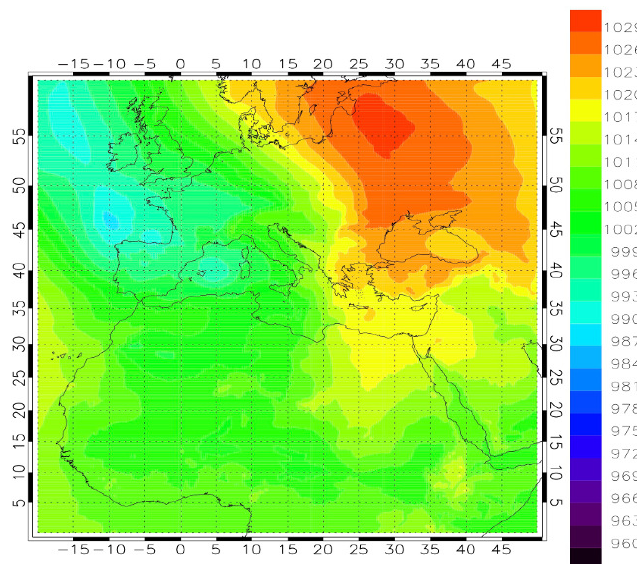
Figure 10. Mean sea level pressure (hPa) at 00 UTC on 23 April 2019. The maps are generated using Copernicus Climate-Change Service Information (2015–2019).